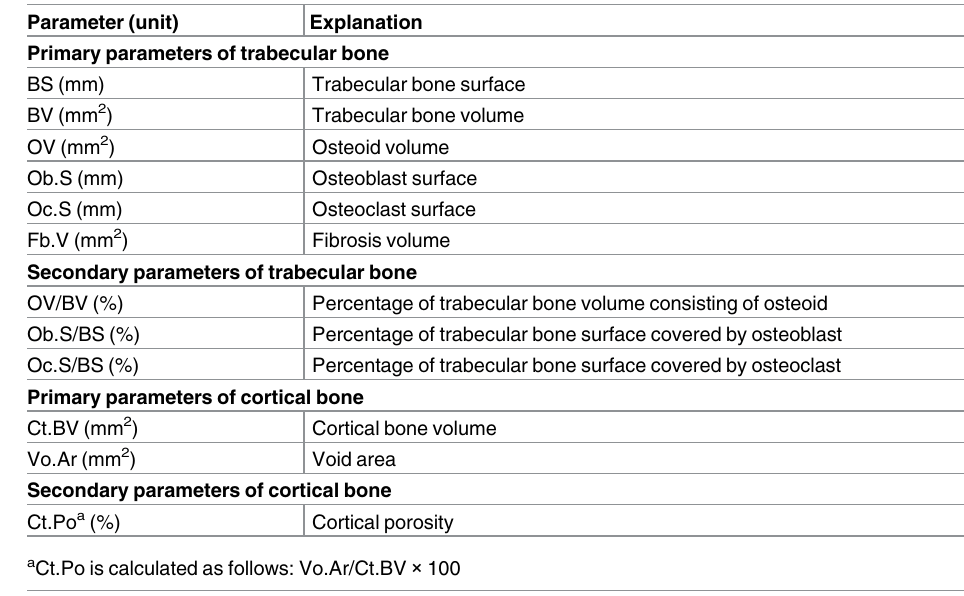
Table 2. Bone histomorphometric parameters measuredin this